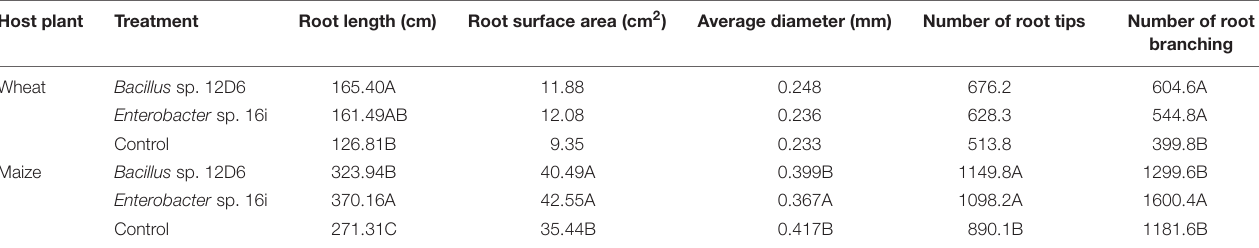
TABLE 2 | Pairwise comparisons using Fischer’s LSD test ( n = 10) of wheat and maize root system architecture with and without plant growth-promoting rhizobacteria (PGPR) inoculation, analyzed using WinRHIZO software. Host